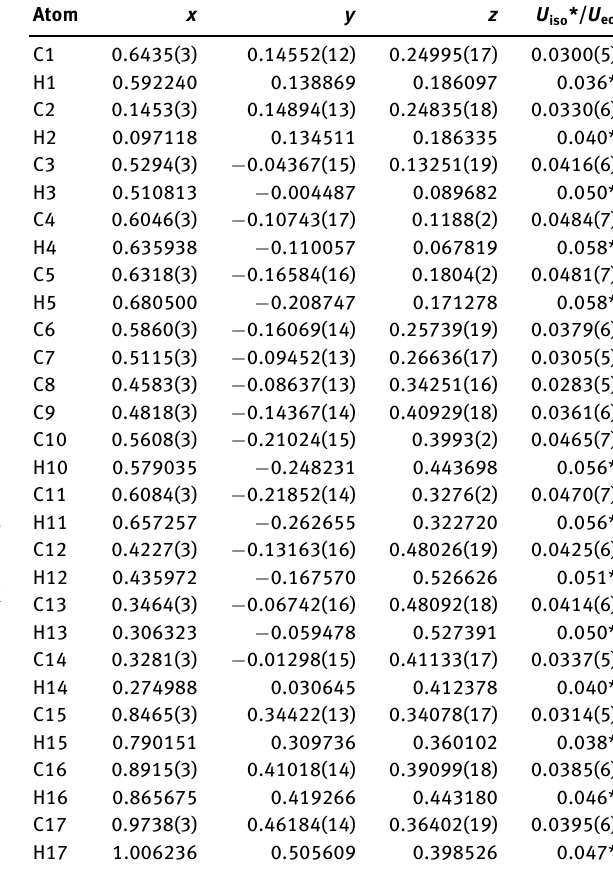
Table 2: Fractional atomic coordinates and isotropic or equivalent isotropic displacement parameters (Å 2